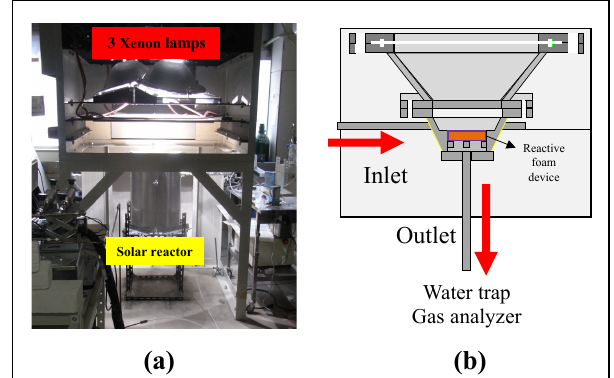
Figure 6. ( a ) Photograph of a 3 kW th sun-simulator. ( b ) Schematic diagram of solar reactor with a reactive foam device for the two-step water-splitting cycle. Table 2. Experimental conditions of the two-step water-splitting cycle with reactive foam device using 3 kW th sun-simulator.